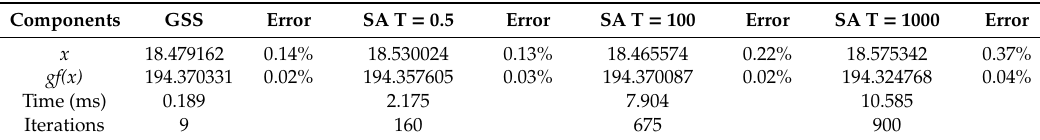
Table 3. Results of the algorithms for the test function 0.